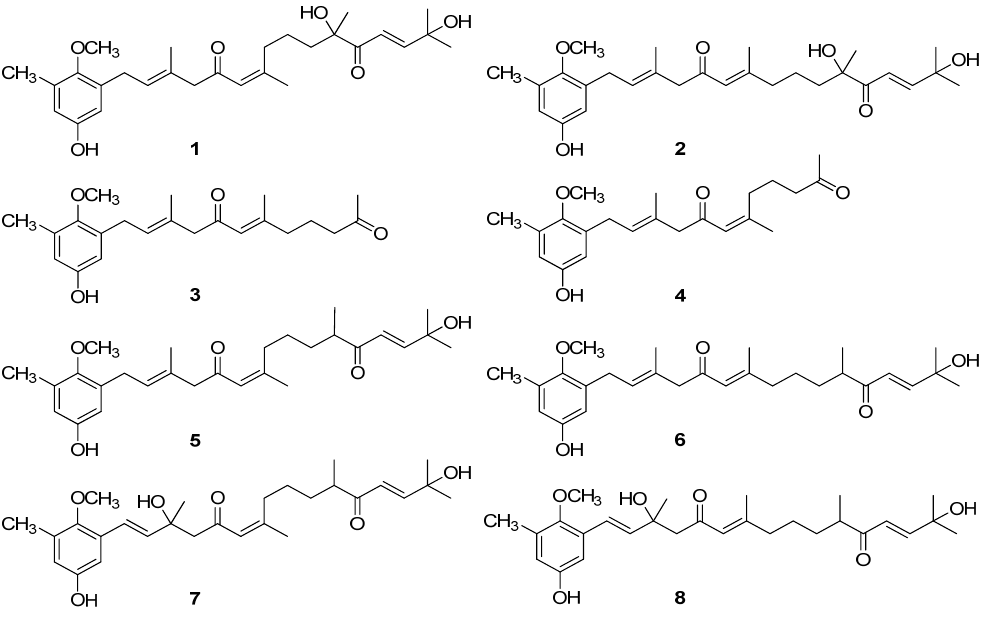
Figure 1. Chemical structures of the meroterpenes (algal meroterpenoids—AMTs) Figure 1 . Chemical structures of the meroterpenes (algal meroterpenoids—AMTs) from the alga from the alga Cystoseira usneoides subjected to anticancer studies: usneoidone Z Cystoseira usneoides subjected to anticancer studies: usneoidone Z ( 1 ), ( 1 ), 11-hydroxy-1 (cid:48) -O-methylamentadione ( 2 ), cystomexicone B ( 3 ), cystomexicone A ( 4 ), 11-hydroxy-1 ′ -O-methylamentadione cystomexicone cystomexicone 6-cis-amentadione-1 (cid:48) -methyl ether ( 5 ), amentadione-1 (cid:48) -methyl ether ( 6 ), cystodione A ( 7 ), and 6-cis-amentadione-1 ′ -methyl ether ( 5 ), amentadione-1 ′ -methyl ether ( 6 ), cystodione A ( 7 ), and cystodione B ( 8 ). cystodione B ( 8 ). Table 1. IC 50 values ( μ g/mL) obtained for meroterpenes (AMTs) 1 - 8 against the colon cancer cells HT-29 and the normal colon cells CCD 841 CoN after 72h of treatment (data are means ± SE of three experiments). SI = IC 50 value for normal cells/ IC 50 value for cancer cells.